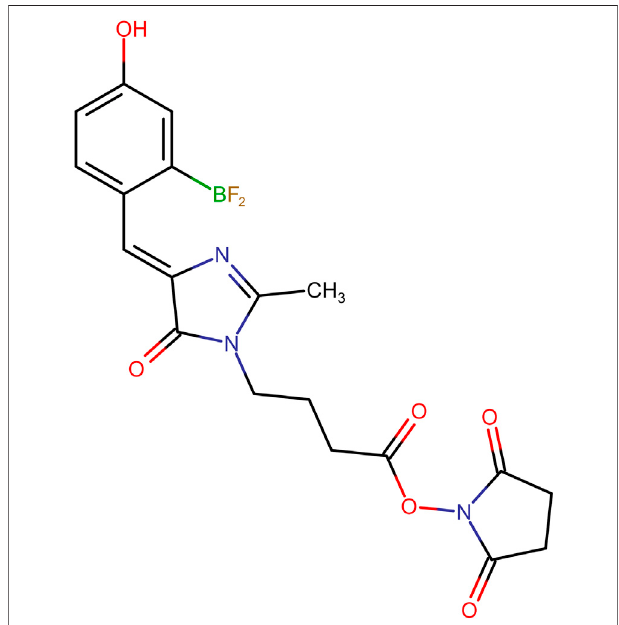
FIGURE 2 | Chemical structure of (Z)-2,5-dioxopyrrolidin-1-yl 4-(4-(2- (di fl uoroboryl)-4-hydroxybenzylidene)-2-methyl-5-oxo-4,5-dihydro-1H- imidazol-1-yl)butanoate ( p -HOBDI-BF 2